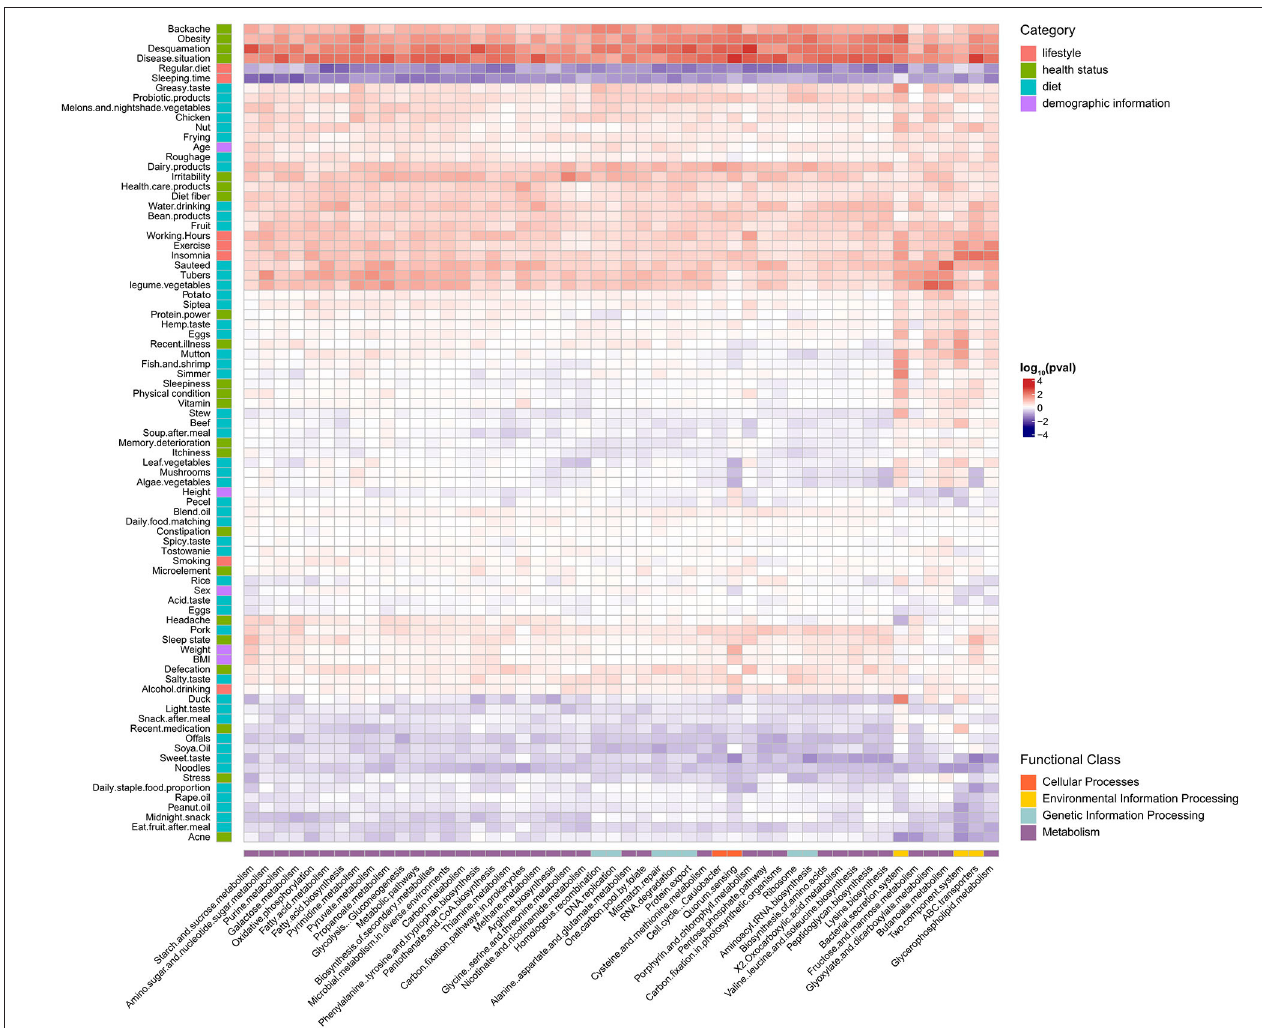
FIGURE 6 | Associations between microbial pathways and multiple factors. Shown is a heatmap of the microbial pathways (x-axis) that were found to be significantly associated with different factors (y-axis) using generalized linear models adjusted for confounding factors. The significant heatmap cells are represented by the direction of association (indicated by color, e.g., red is positively associated). Each factor is colored by the category to which it belongs, and each microbial pathways is colored by the functional class to which it